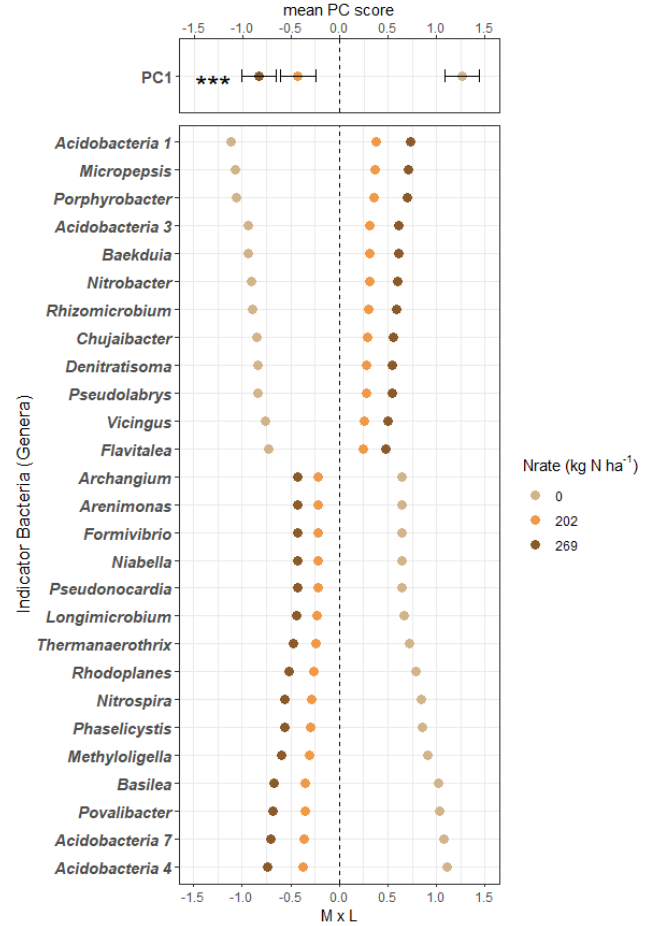
Figure 1. The top panel shows the estimated mean principal component (PC) scores of the bacterial PC1 for each level of N rate treatment with their standard errors as whiskers. The asterisks indicate the probability value of the treatment effect from analysis of variance (***: p < 0.001). The bottom panel shows the contribution of each bacterial indicator (genera) to PC1 multiplied by the mean PC scores of each level of N treatment (M × L). The treatment levels are: 0 kg N ha − 1 (tan), 202 kg N ha − 1 (orange), and 269 kg N ha − 1